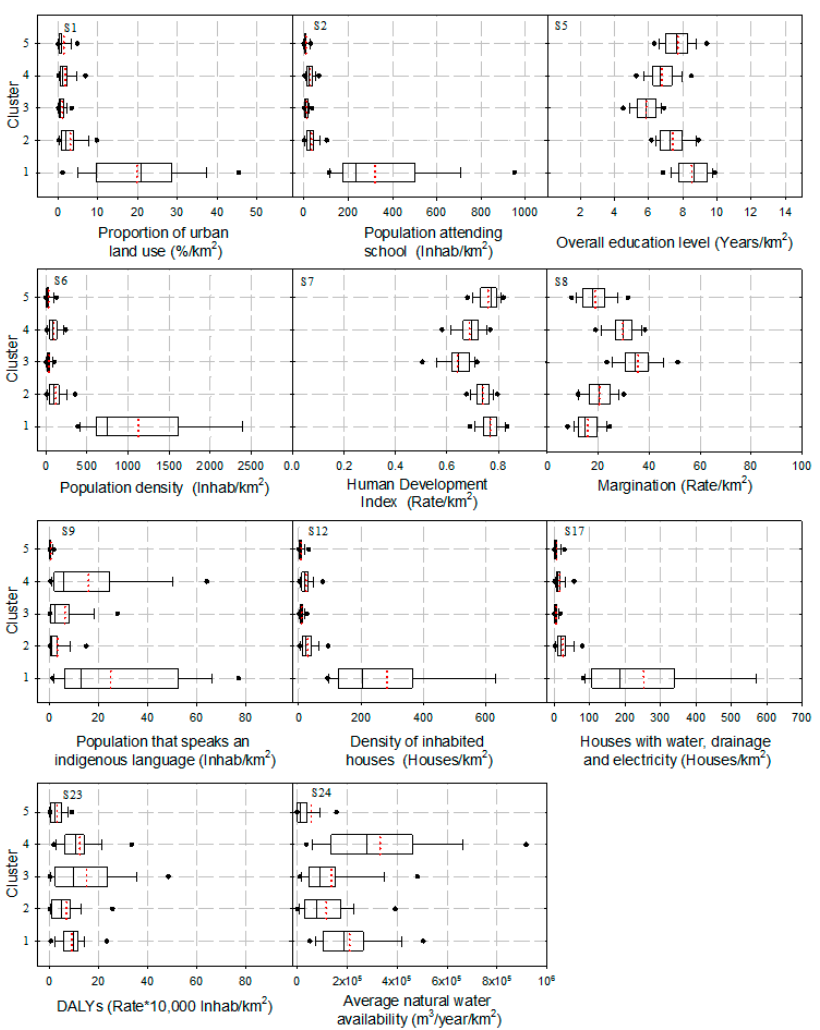
Figure 7. Regional social characteristics with real values. Average value is the dotted red line.